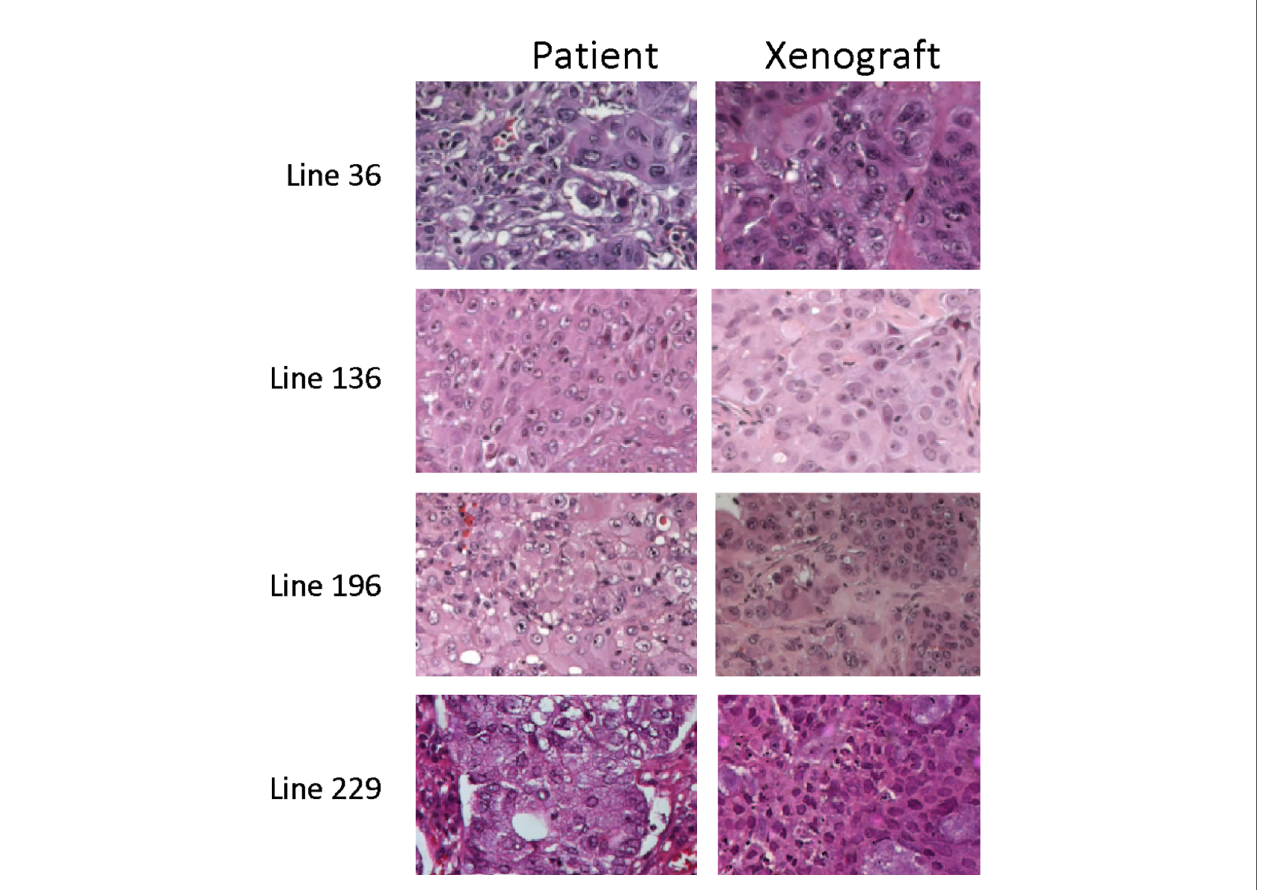
FIGURE 4 | Representative images of the histology of tumor xenograft and of corresponding patient tumors. Hematoxylin and eosin images of matching tumor tissue from parental patient tumors and explanted CSC-derived tumor